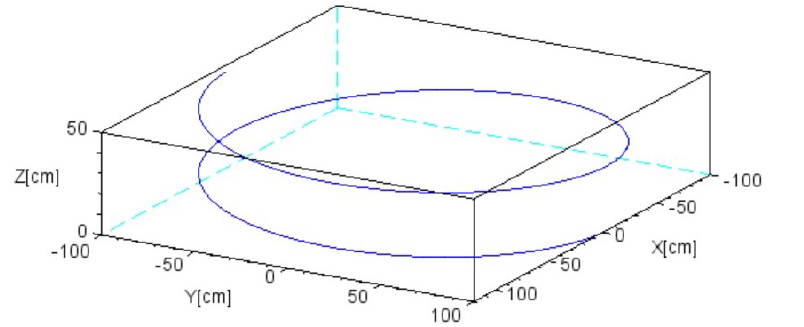
Figure 6. Experiment 2. Nominal path followed by the leader drone suffering a sudden lateral distur- bance.